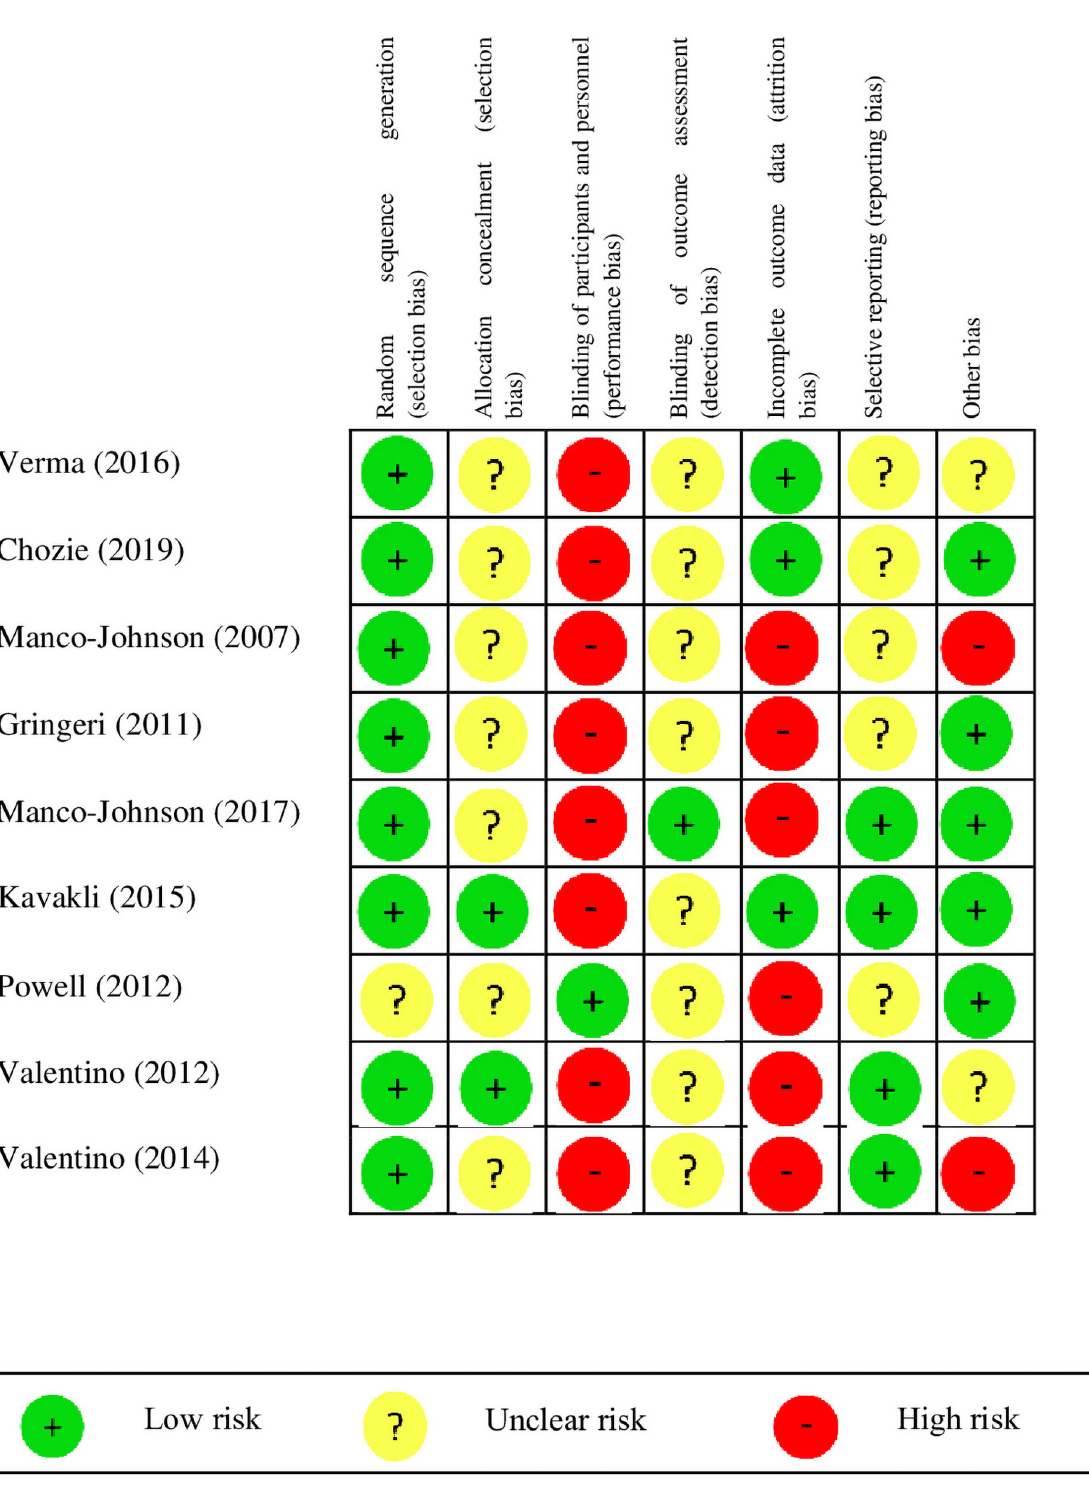
Fig 2. Risk of bias of the included studies.